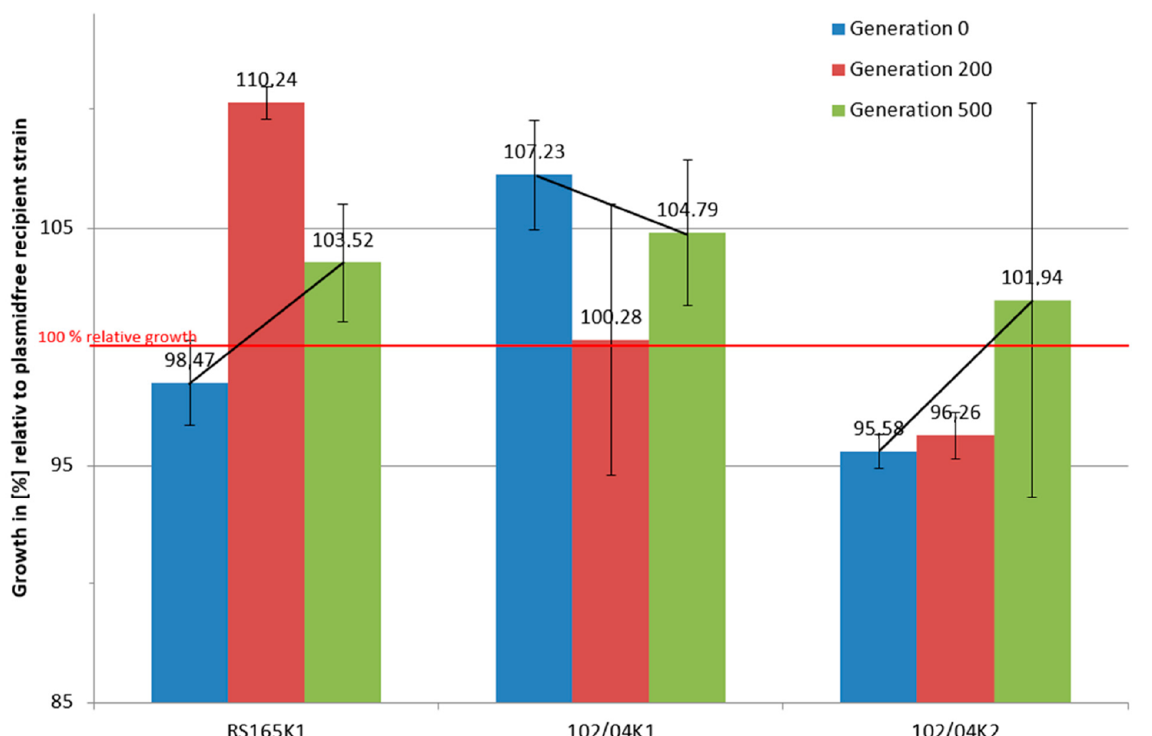
Figure 2. Development of the relative fitness of transconjugants 102/04 K1, 102/04 K2 and RS165 K1 compared to the recipient during long-term cultivation for 500 generations. Aggregated values at the start point (G 0 ), after 200 generations (G 200 ) and 500 generations (G 500 ) are shown. Error bars depict standard deviations from three independent experiments (mean values from single experiments based on technical triplicates).